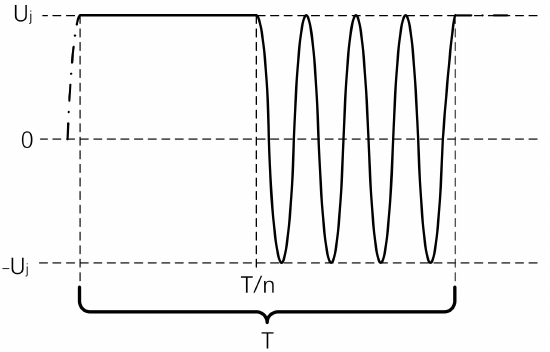
Figure 6. The waveform of the applied voltage, pattern in the solid line indicates a single period of the signal.